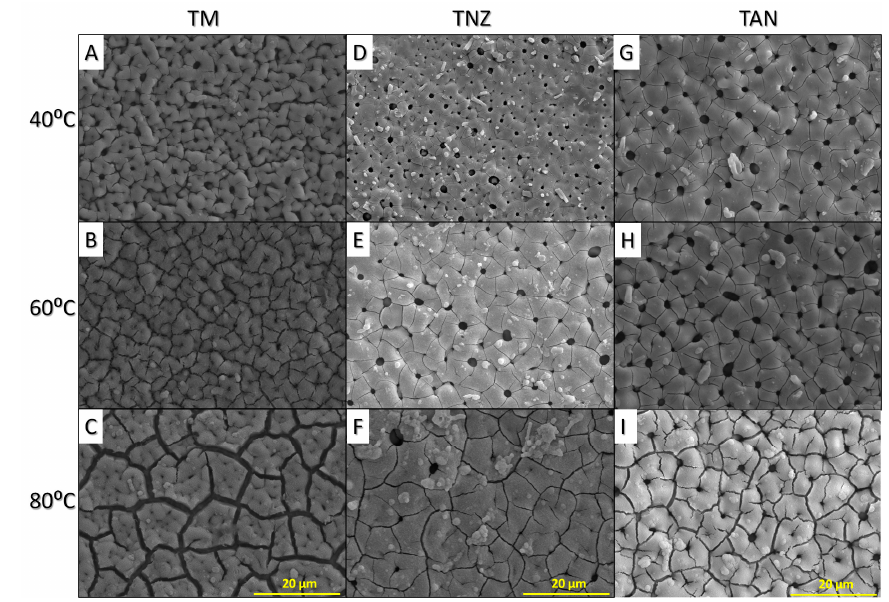
Figure 4. SEM images of the titanium TM ( A – C ), TNZ ( D – F ), TAN ( G – I ) alloy samples after anodization and immersion in 5 M NaOH at various temperatures, for 8 h.